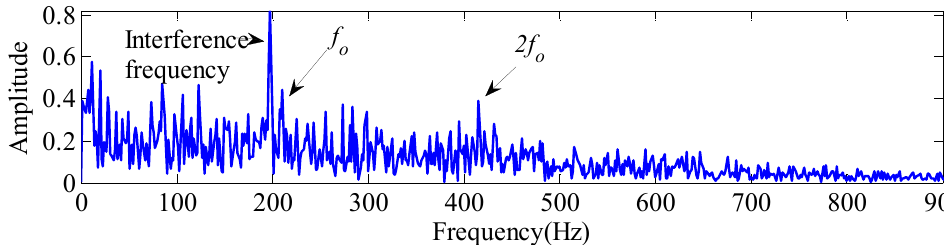
Figure 25. Noise-reducing envelope spectrum diagram of the manually selected signal segments.